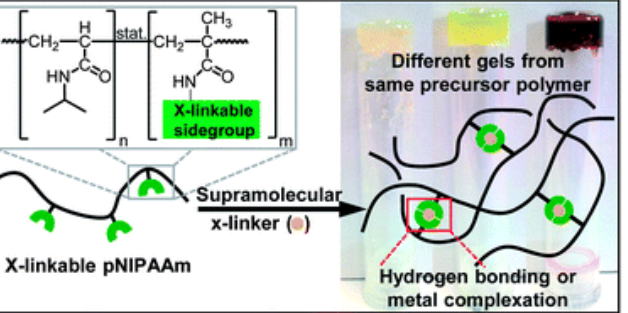
Figure 15. Scheme of the formation of non-covalent bonds in supramolecular systems. Reproduced from [170] with permission from the Royal Society of